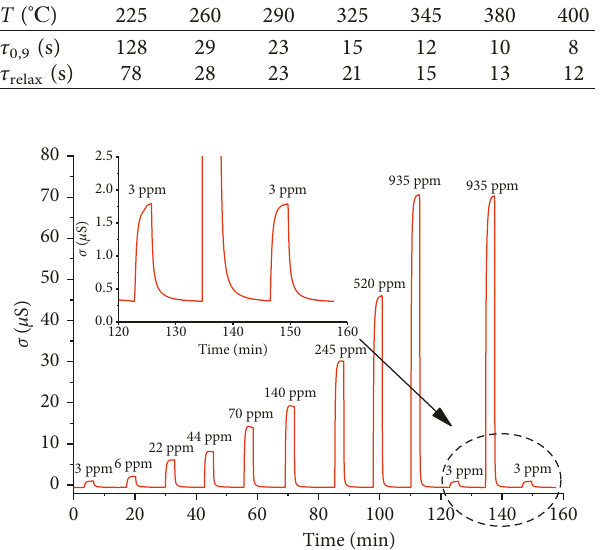
Figure 6: Change in conductivity for the 0.24wt.% Pd/SnO sensor versus stepwise change of hydrogen concentration in gas mixture surrounding the sensors at sensor temperature 260 ° C.